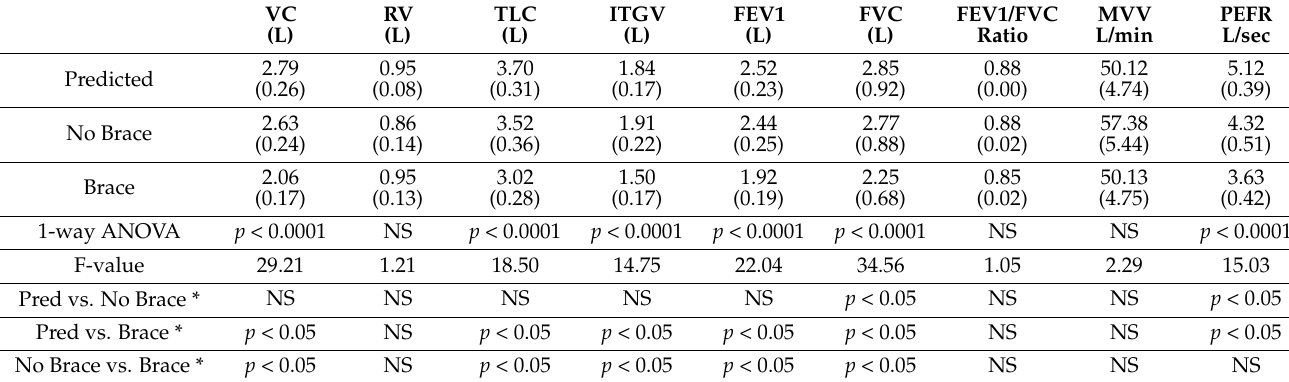
Table 2. Pulmonary function parameters are presented as mean ± standard error of the mean (SEM). The p -values are based on a 1-way ANOVA test for repeated measures and (*) Tukey’s multiple comparison test. VC: vital capacity; RV: residual volume; TLC: total lung capacity; ITGV: intrathoracic gas volume; FEV1: forced expiratory volume in the first second; FVC: forced vital capacity; MVV: maximal voluntary ventilation; PEFR: peak expiratory flow